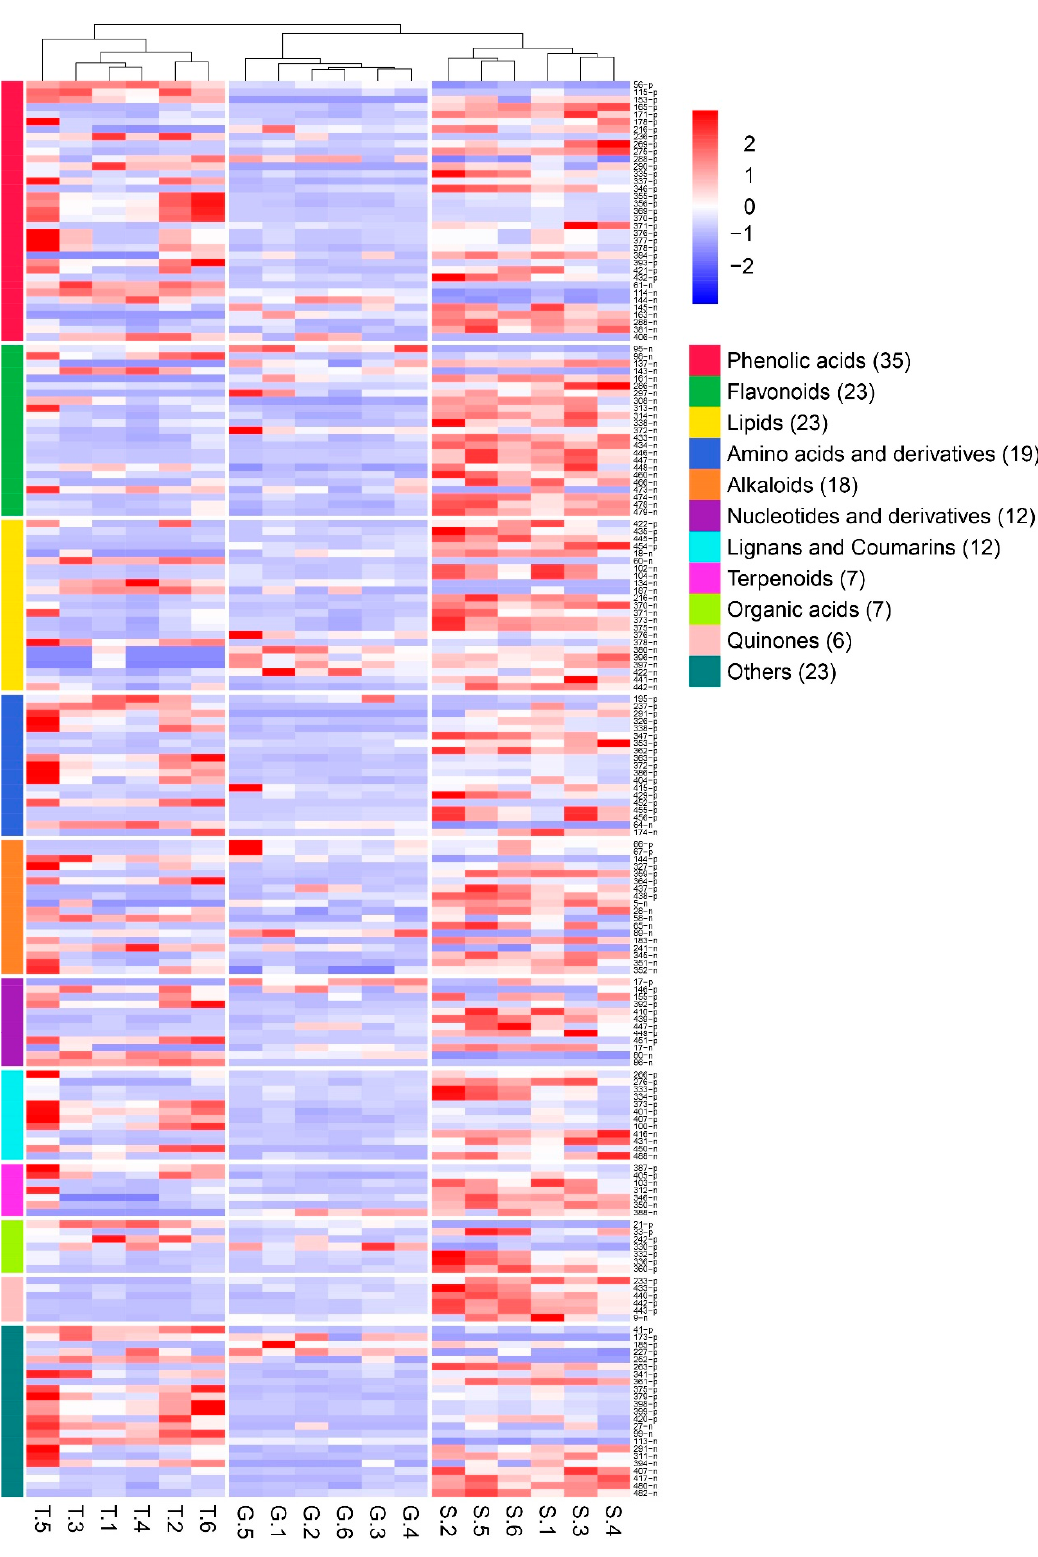
Figure 5. The effects of different cultivation methods on the contents of the changed metabolites ( n = 6). The heat map was used to describe the changes in the metabolite contents. G meant that the sample was from greenhouse cultivation; S meant that the sample was from stone epiphytic culti- vation; T meant that the sample was from live tree epiphytic cultivation. On the left side of the graph, the color was used to show the classification of the metabolites. On the right side of the graph, the number of the metabolite was listed. N meant that the determination was in negative ion mode, and P meant that the determination was in positive ion mode. Re-ID is a ranking of compounds based